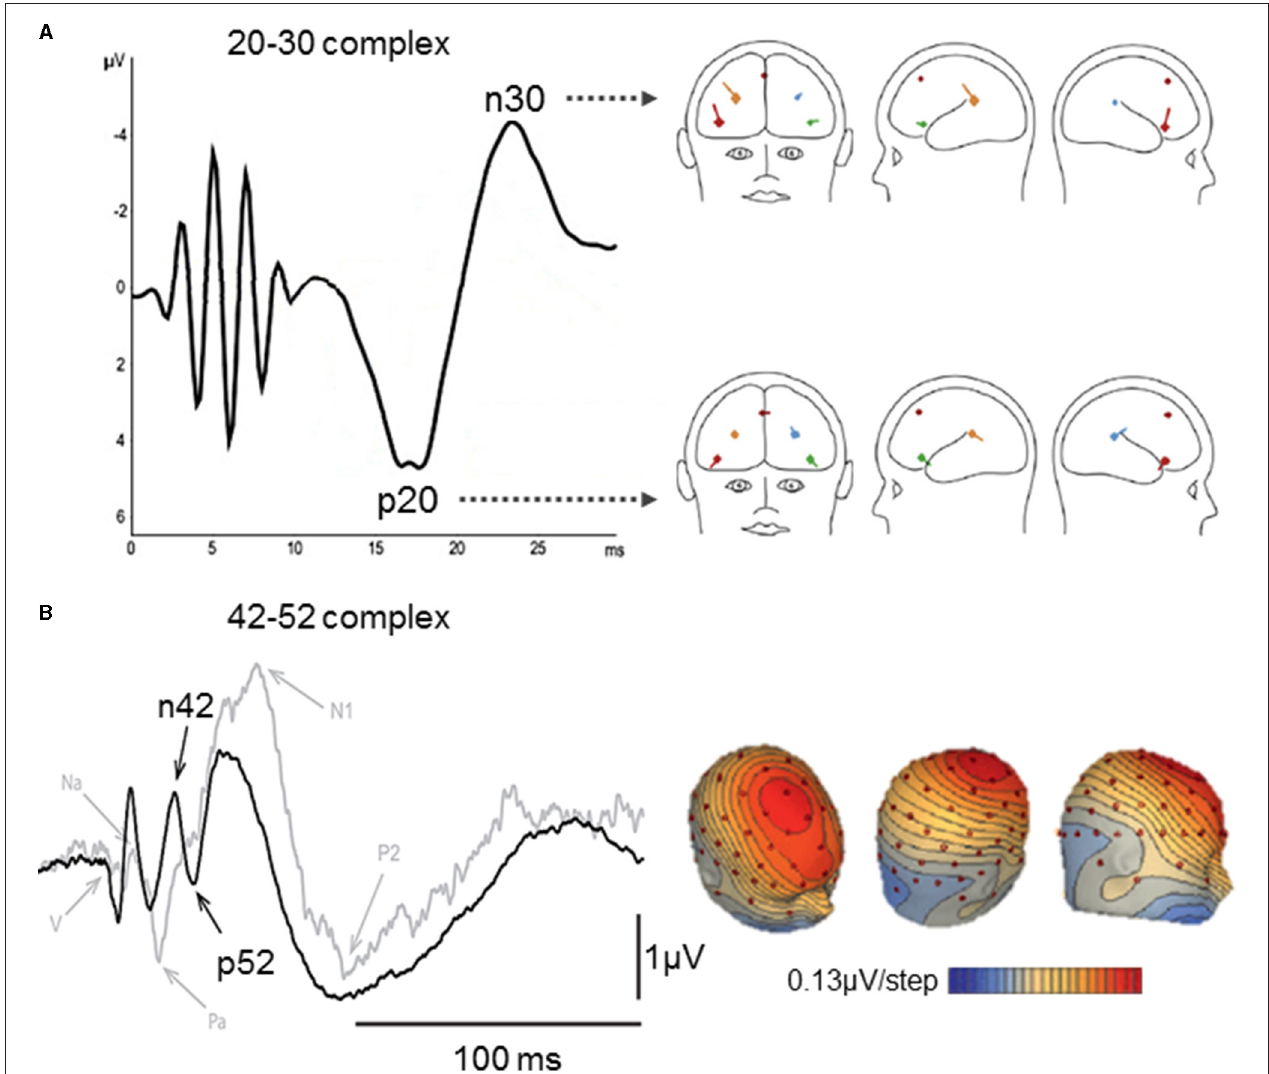
FIGURE 4 | Middle latency vestibular-evoked cerebral potentials (VestEPs). (A) The left part shows the 20–30 complex observed with a Laplacian montage (FC1 + FC2 + IO) – (TP9 + TP10), after short latency responses appearing within 10ms. The right part shows BESA regional source activity for the p20 and n30 components, showing the junction of the anterior insula with the inferior frontal gyrus in the right hemisphere (bright red), the posterior parietal operculum (bright blue), a frontal source near areas 2v, 3aNV, and the frontal eye fields (dark red), the left inferior frontal gyrus (green), the left parietal operculum (brown). Adapted from (111) with permissions from Elsevier. (B) Left panel: Grand means of evoked potentials showing the n42–p52 response under electrode FCz after right acoustic stimulation in 10 healthy subjects (black curve) and a patient with a unilateral vestibular loss (gray curve). Right panel: Scalp voltage maps at 42ms after acoustic stimulation ( + 18 dB above the vestibular threshold). Positive potentials are indicated in blue and negative in red and contours are spaced at 0.13 µ V. Adapted from